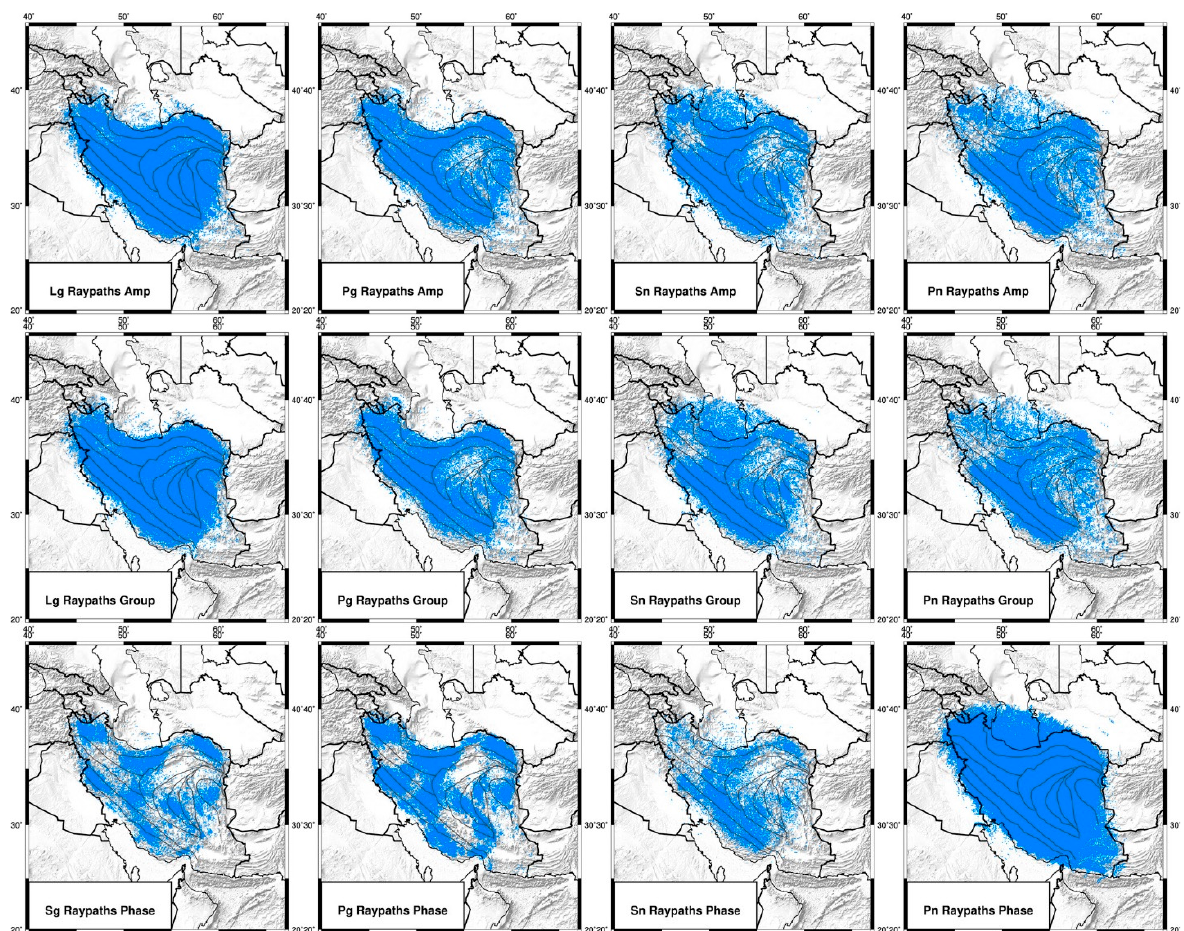
Figure 4. Raypaths. Drawing complete raypaths saturates the images, s only every 21st element of each raypath is plotted. While this obscures individual raypaths, it shows the coverage well. Note the lack of Sg, Lg, and Pg raypaths beneath the southern Caspian Sea.